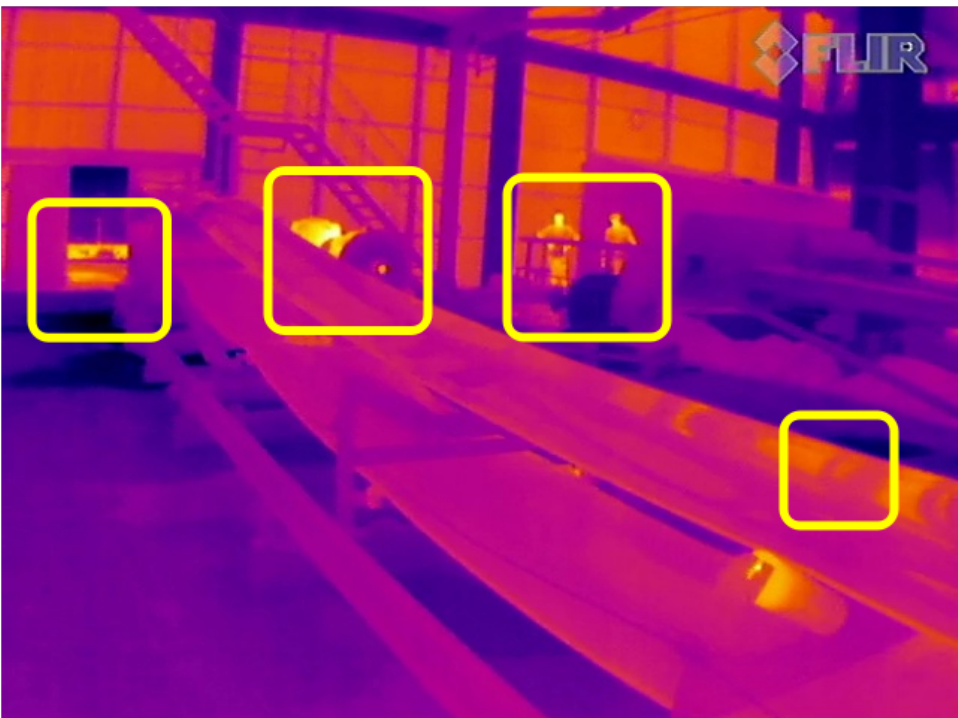
Figure 11. Examples of hotspots that are not related to